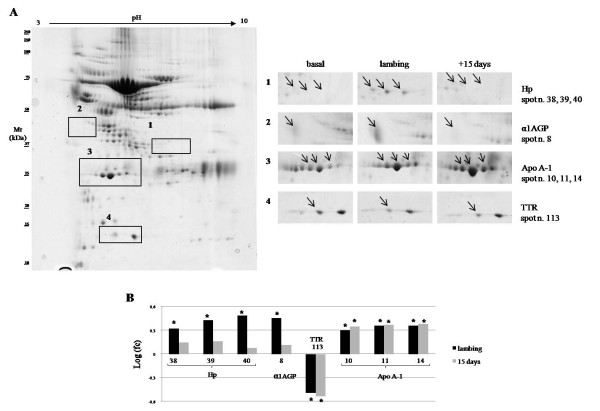
Differential 2-DE analysis of sheep serum during peripartum.A) 2-DE serum sheep map and expanded view of the gel portions including the deregulated proteins during peripartum. Spot proteins differing by > 2 fold (P < 0.05) in sheep at lambing (lambing), 15 days after lambing (+15 days) compared to sheep two months before lambing (basal) were indicated. Area 1: spots identified as Hp; Area 2: spots identified as α1AGP; Area 3: spots identified as Apo A-1; Area 4: a spot identified as TTR. B) Histograms representing log fold change (calculated as a ratio of average density spots at lambing and +15 days vs basal). *: Spots with fold change more than 2 or less than 0.5 with statistically significant P < 0.05. Black and grey bars correspond to lambing vs basal and +15 vs basal respectively.